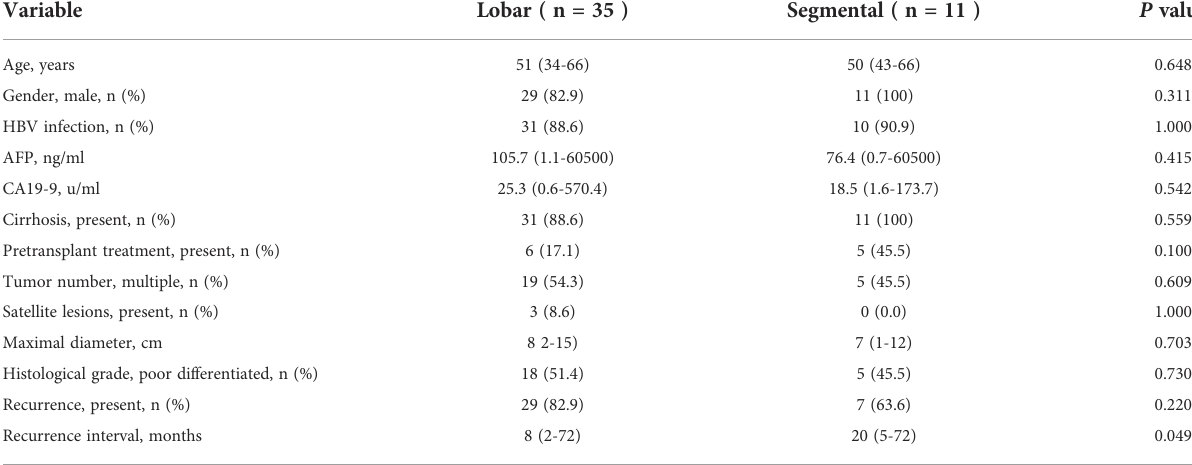
TABLE 3 Comparisons of patients receiving LT with HCC by different PVTT